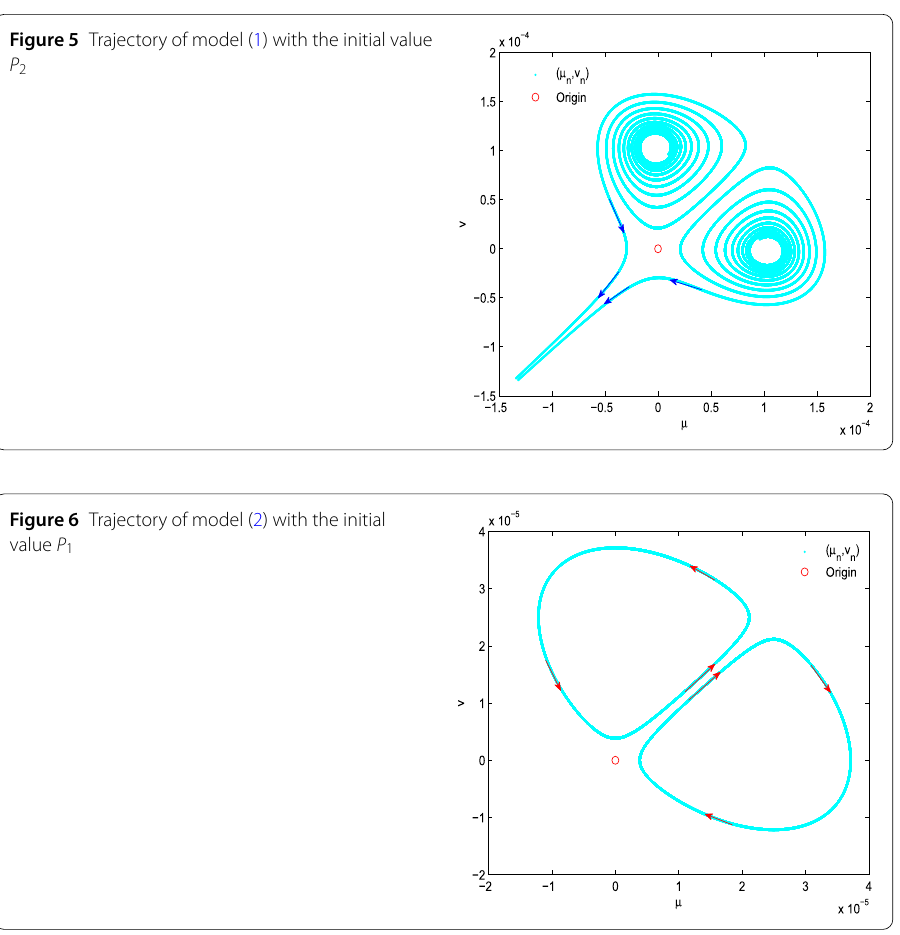
Figure 5 Trajectory of model (1) with the initial value P